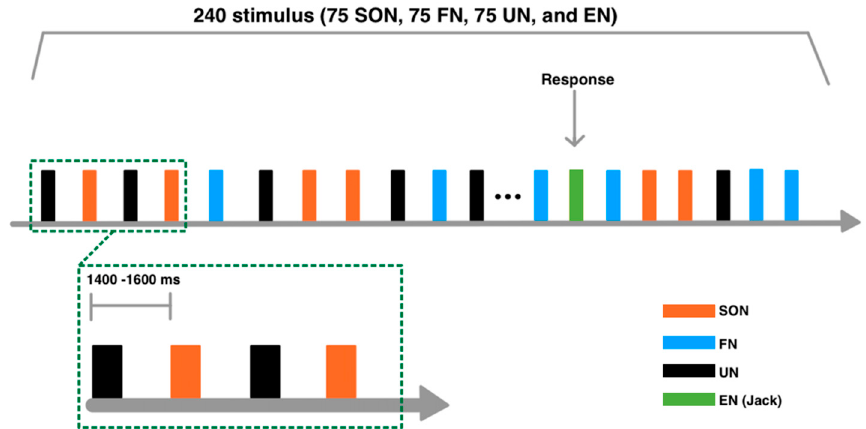
Figure 1. Experimental paradigm. A total of 960 trials were presented in four blocks, each consisting of 240 trials. Subjects were required to keep their eyes open and fixate on a white cross displayed on a black screen. In all blocks, subjects listened to the names and pressed the button with their right index finger when they heard JACK. Four types of auditory stimuli were used: subject’s own name (SON), a friend’s name (FN), an unknown name (UN), and an English name (EN: JACK).